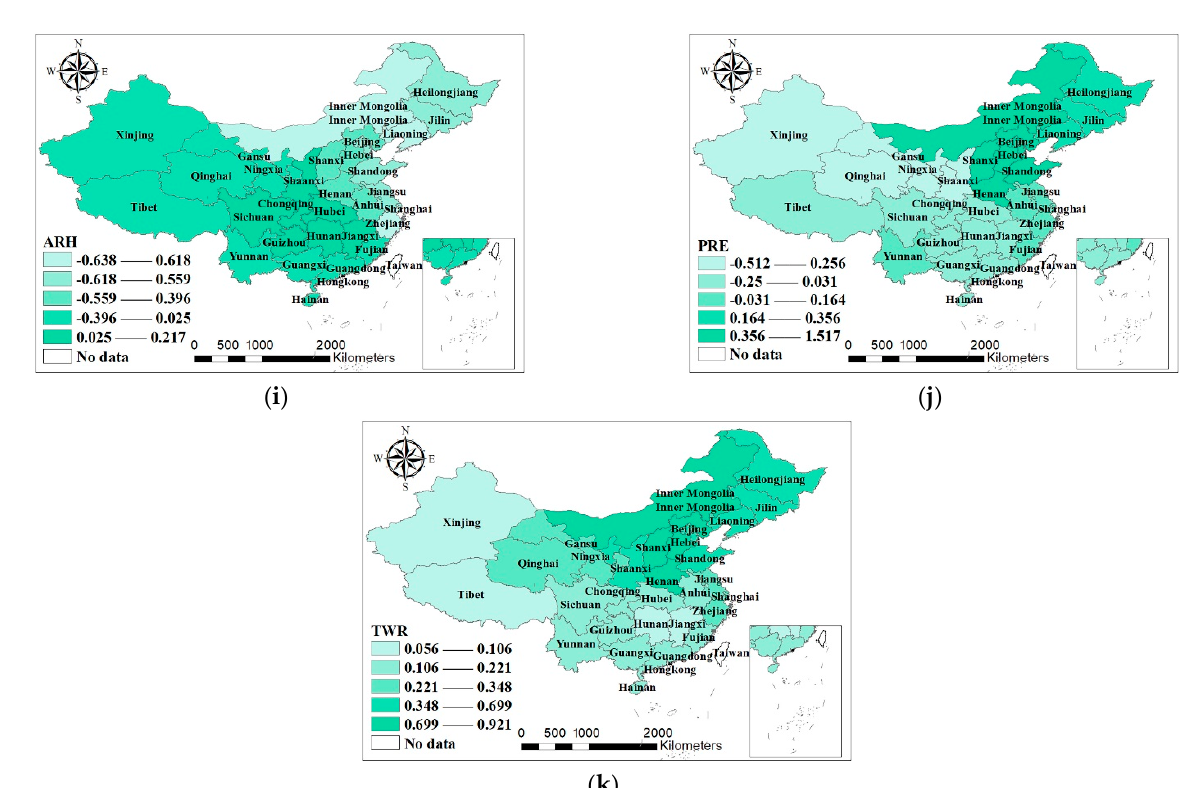
Figure 3. Spatial patterns of coefficients in the MGWR. ( a ) Number of Internet users, ( b ) total sown areas of farm crops, ( c ) population, ( d ) total number of chain retail enterprises, ( e ) GDP per capita, ( f ) value addition of primary industry, ( g ) investment in fixed assets of agriculture, forestry, animal husbandry and fishery, ( h ) per capita disposable income of urban households, ( i ) average relative humidity. ( j ) precipitation, and ( k ) total water resources.